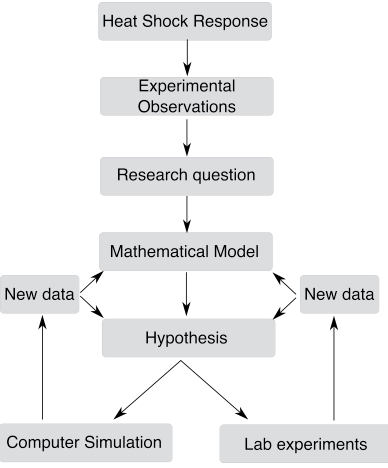
Figure 2. Overview of the mathematical modeling